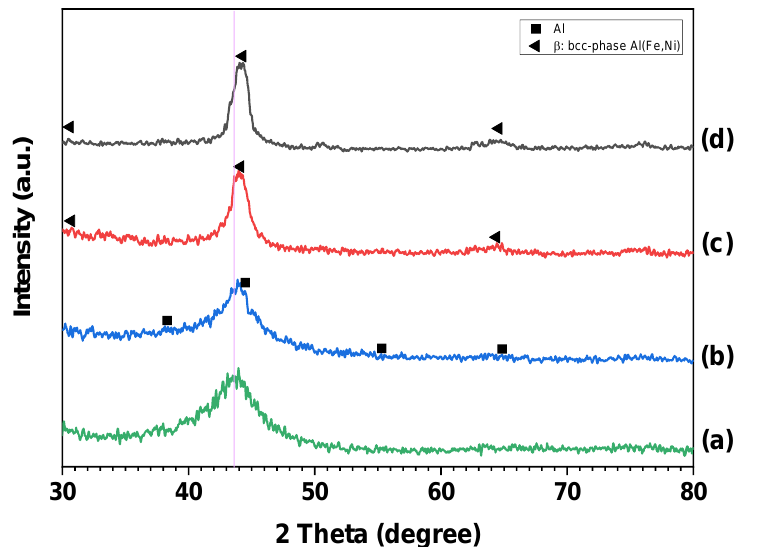
Figure 10. XRD patterns of amorphous Al 82 Fe 14 Ni 4 samples ( a ) after milling for 60 h, ( b ) sintered at 450, ( c ) 500 and ( d ) 600 °C.